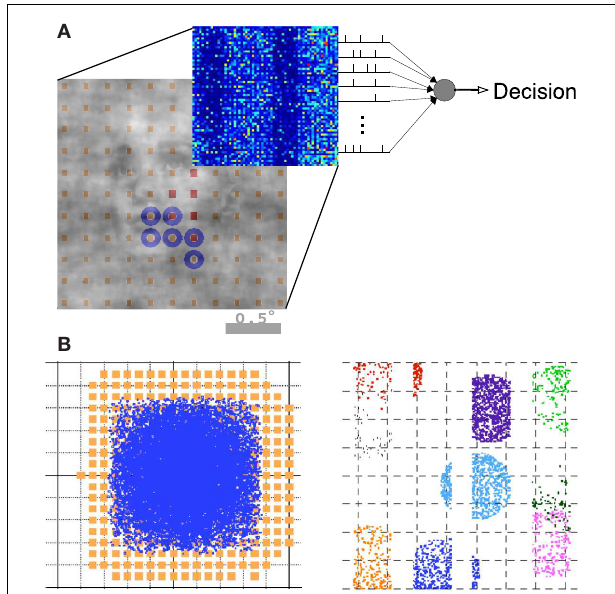
FIGURE 2 | Summary of the model architecture. (A) The model is comprises of the encoding and decoding components. (B) Architecture of theV1 model, where receptive fields and LGN axon targets are viewed in the visual space (left) and cortical space (right). Details can be found in Wielaard and Sajda